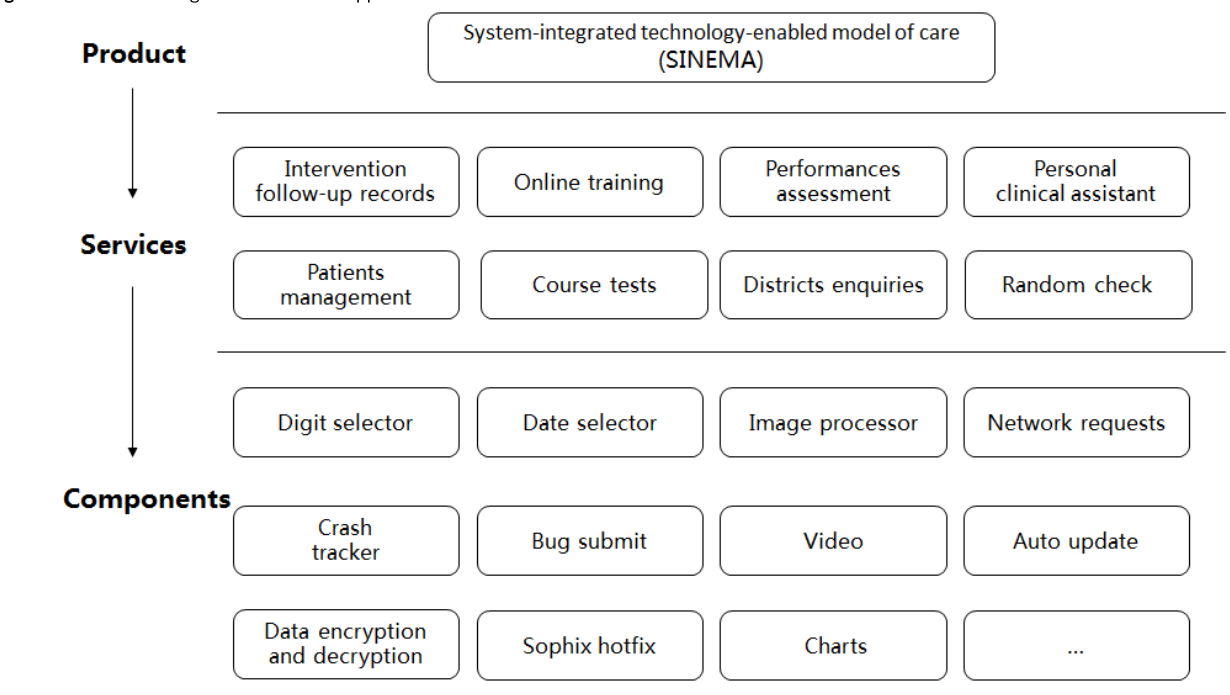
Figure 5. Modular design of the Android app